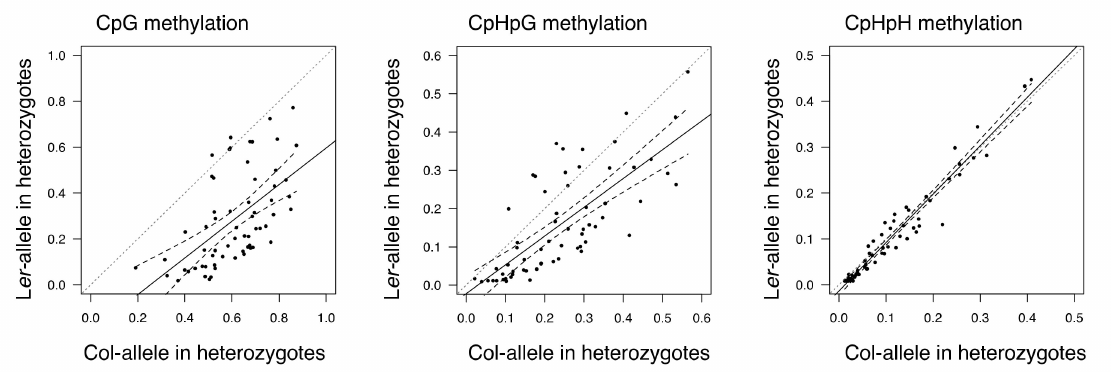
Figure 2. Methylation level correlation between Col and L er alleles in F 2 heterozygotes. Plot of methylation level correlation between Col and L er alleles in F 2 heterogyzotes. Solid lines represent best-fit linear regression lines. Dashed lines represent 95% lower and upper bounds of regression.